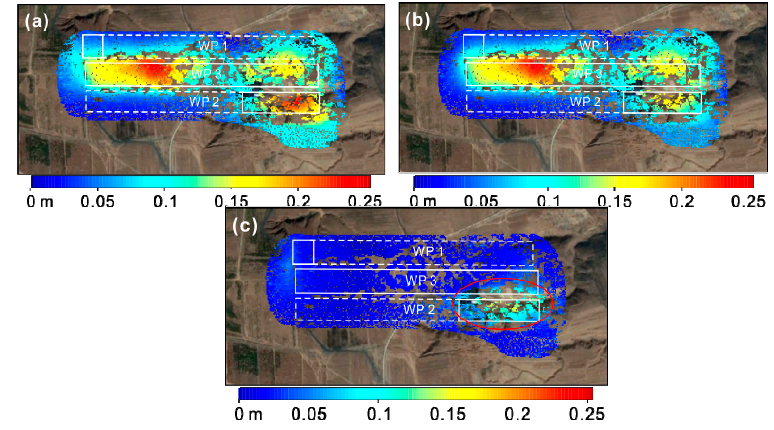
Figure 9. ( a – c ) Fitting residuals between the 17 InSAR observation maps and the synchronous ones estimated by the linear model, the cubic polynomial model, and the logistic model.